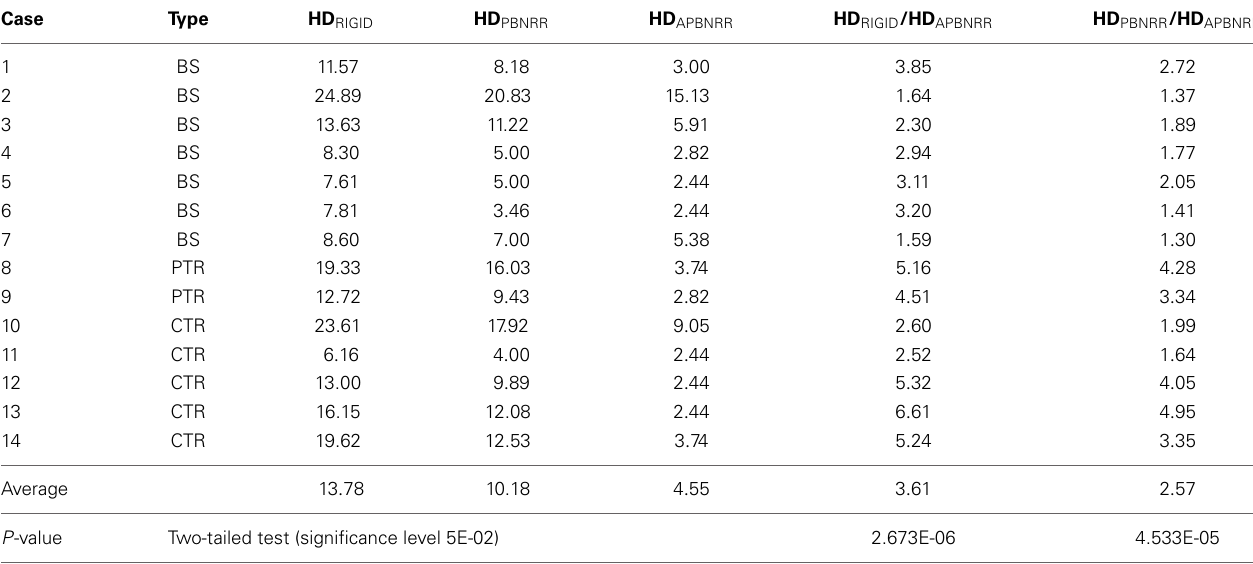
Table 4 | The quantitative evaluation results for the 14 clinical cases.